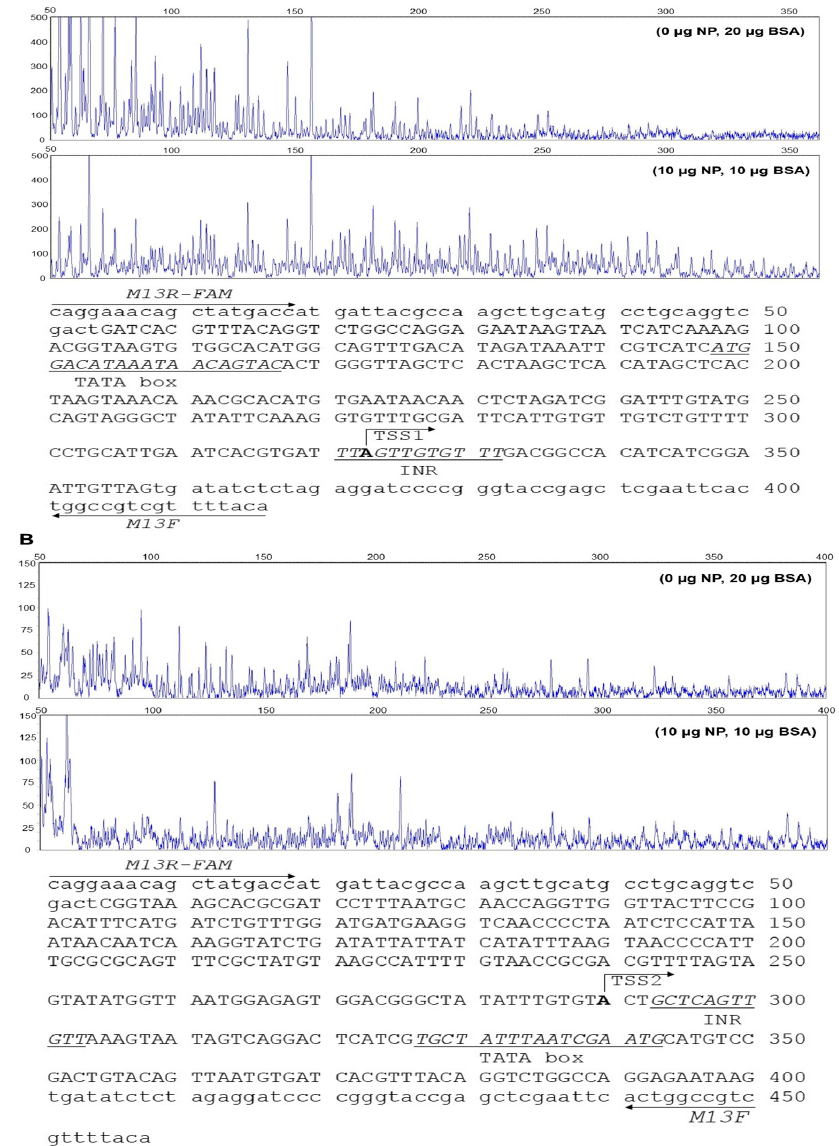
Figure 2. DNase I foot printing assay of proximal promoter of CPT I α 1b . ( A ) 303-bp proximal promoter region of CPT I α 1b ( B ) 346-bp proximal promoter region of CPT I α 1b . The sequence used for